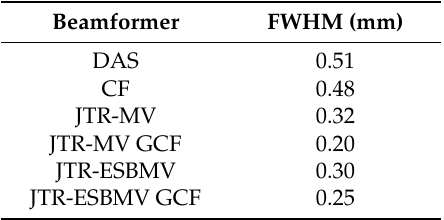
Table 4. FWHM for the experimental point target at z = 9